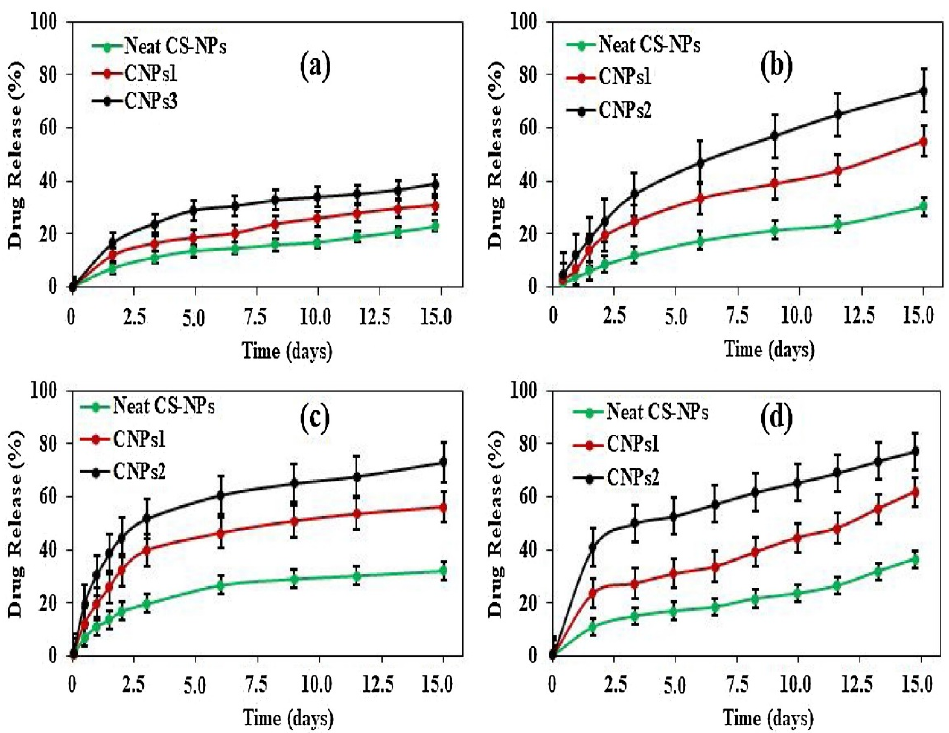
Figure 4. Diclofenac-embedded pure CS-NPs, CNPs1, and CNPs2 in vitro release of drugs studied at 37 °C in varying acid levels and environmental conditions: ( a ) pH 2, ( b ) pH 6, ( c ) pH 7.4, and ( d ) pH 9. The results are presented as an average deviation of ±3. Reproduced with permission from [34].